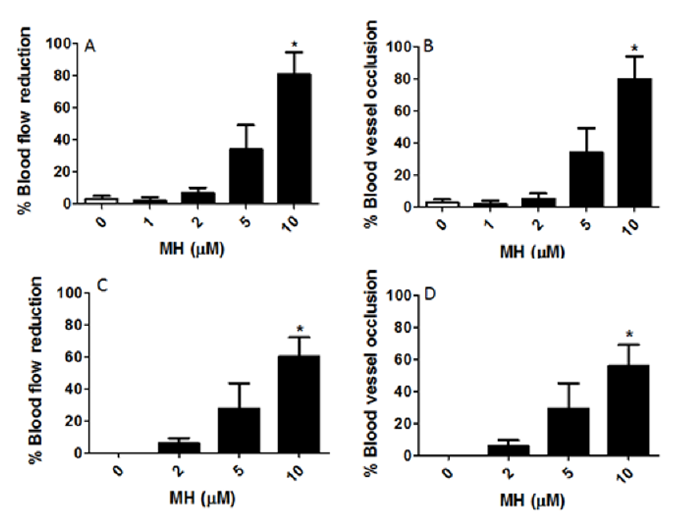
Figure 3. Reduction of blood flow and vascular occlusion by MH. Embryos were exposed to 1, 2, 5, and 10 µ M MH from 5 h post fertilization (hpf) to 6 dpf (0–6 dpf, ( A , B )) or from 2 dpf to 6 dpf (2–6 dpf, ( C , D )).